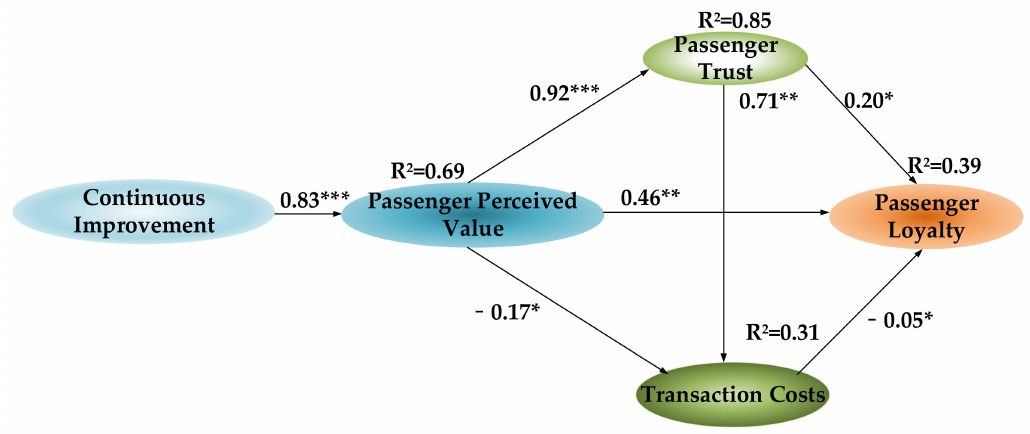
Figure 6. Parameter Estimation of the Theoretical Model.